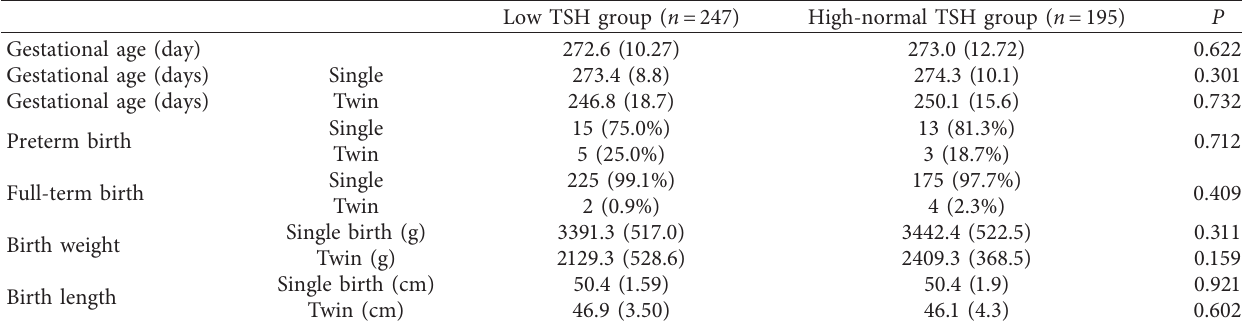
Table 4: The obstetric outcomes of the women undergoing the first single D5 blastocyst